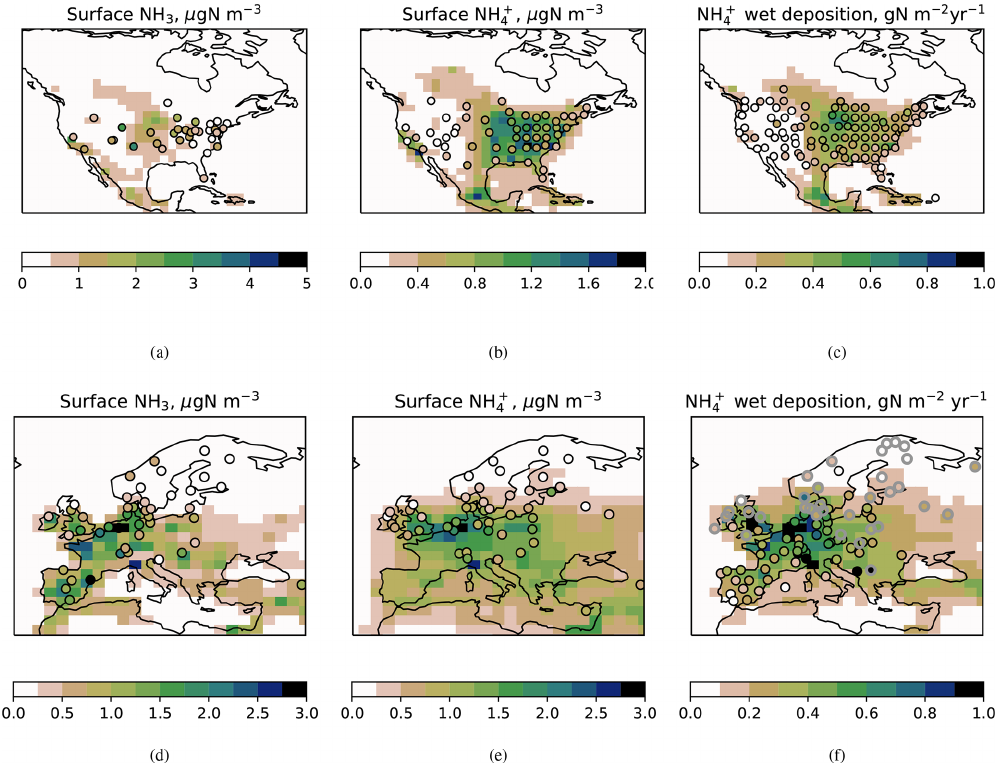
Figure 3. Ammonia (a, d) , ammonium (b, e) and wet deposition of ammonium (c, f ) in the FAN simulation for North America and Europe ( a–c and d–f , respectively). Observed values are shown by markers. Grey markers in panel (f) denote wet deposition observations from bulk samplers which are not used for calculating statistical parameters. The other simulations are shown in Figs. S5 and S6.